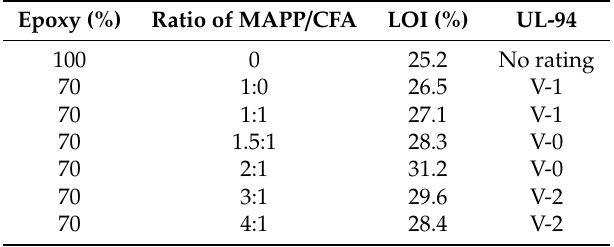
Table 4. Flame retardance results of Epoxy / IFR with di ff erent ratio of MAPP / CFA. Epoxy (%) Ratio of MAPP / CFA LOI (%) UL-94